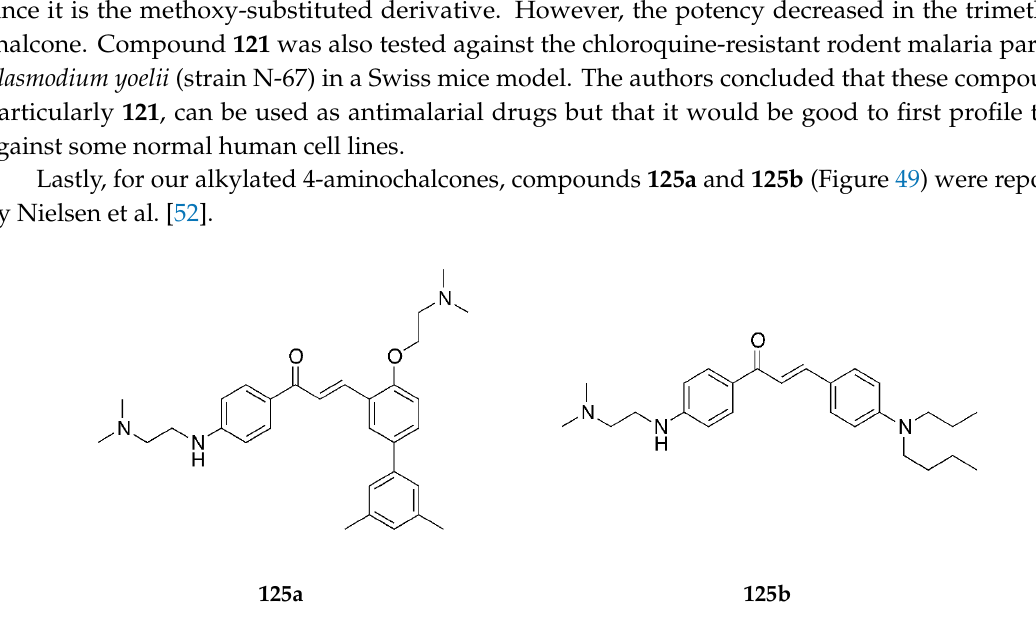
Figure 49. Chemical structures of mono alkylated 4-aminochalcones derivatives.